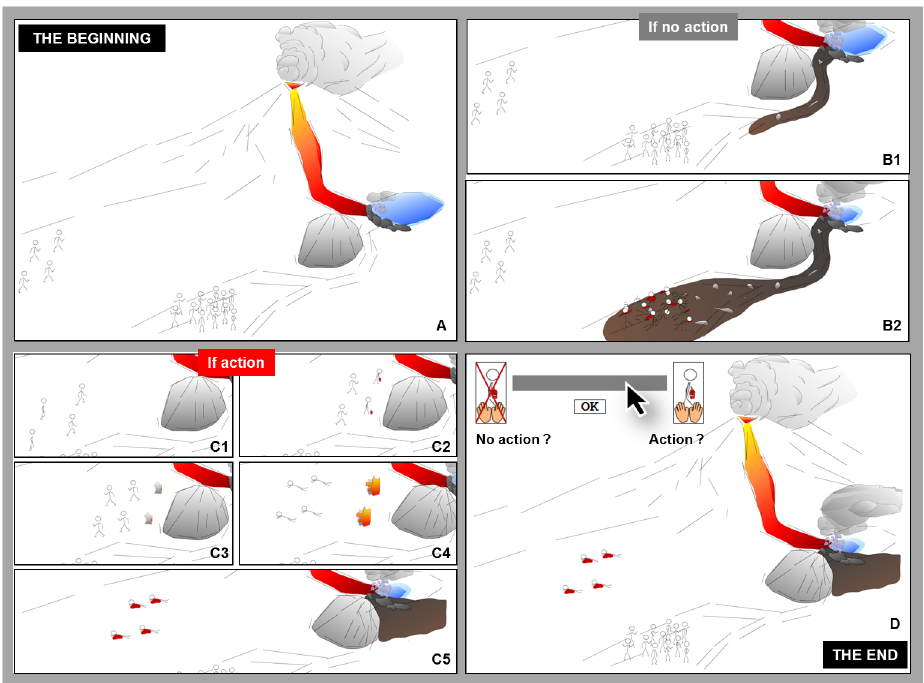
Fig 2. Examples of the progress of the animated intentional scenarios for the loss frame effect, where some individuals are sent to their inescapable fate by dynamiting a rocky pan to stop the progress of a lahar. Notes: (A) a lava flow is about to collapse the lake; If no action: (B1) the collapsed lake would release a lahar and (B2) kill the inhabitants; If action: (C1) some individuals can be sent to a rocky pan and (C2) use dynamite to divert the course of the lahar, but (C3,C4) the individuals won’t be able to flee from the explosion and (C5) they would be killed by the explosion to save the other inhabitants; (D) participants have to use the grey bar to give their